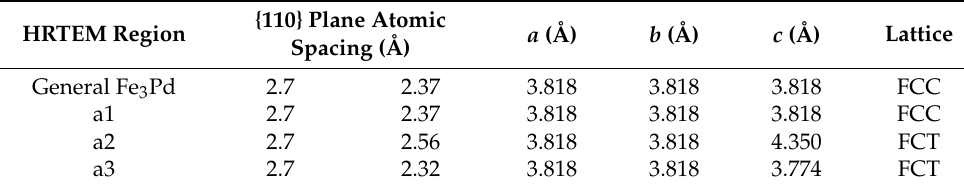
Table 1. Structure parameters of recrystallized